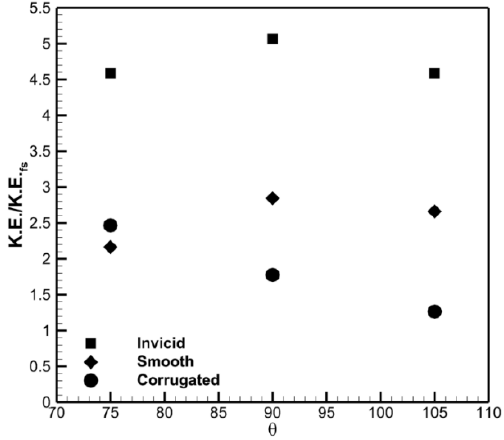
Figure 16. Normalized kinetic energy from measured velocity profiles. Re = 7.7 × 10 5 .